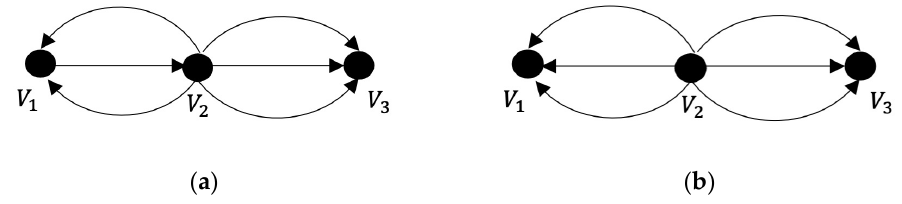
Figure 7. Multidigraph ( a ) Autocatalytic set ( b ) Non-autocatalytic set. Both multidigraphs in Figure 7 are not cyclic as well.